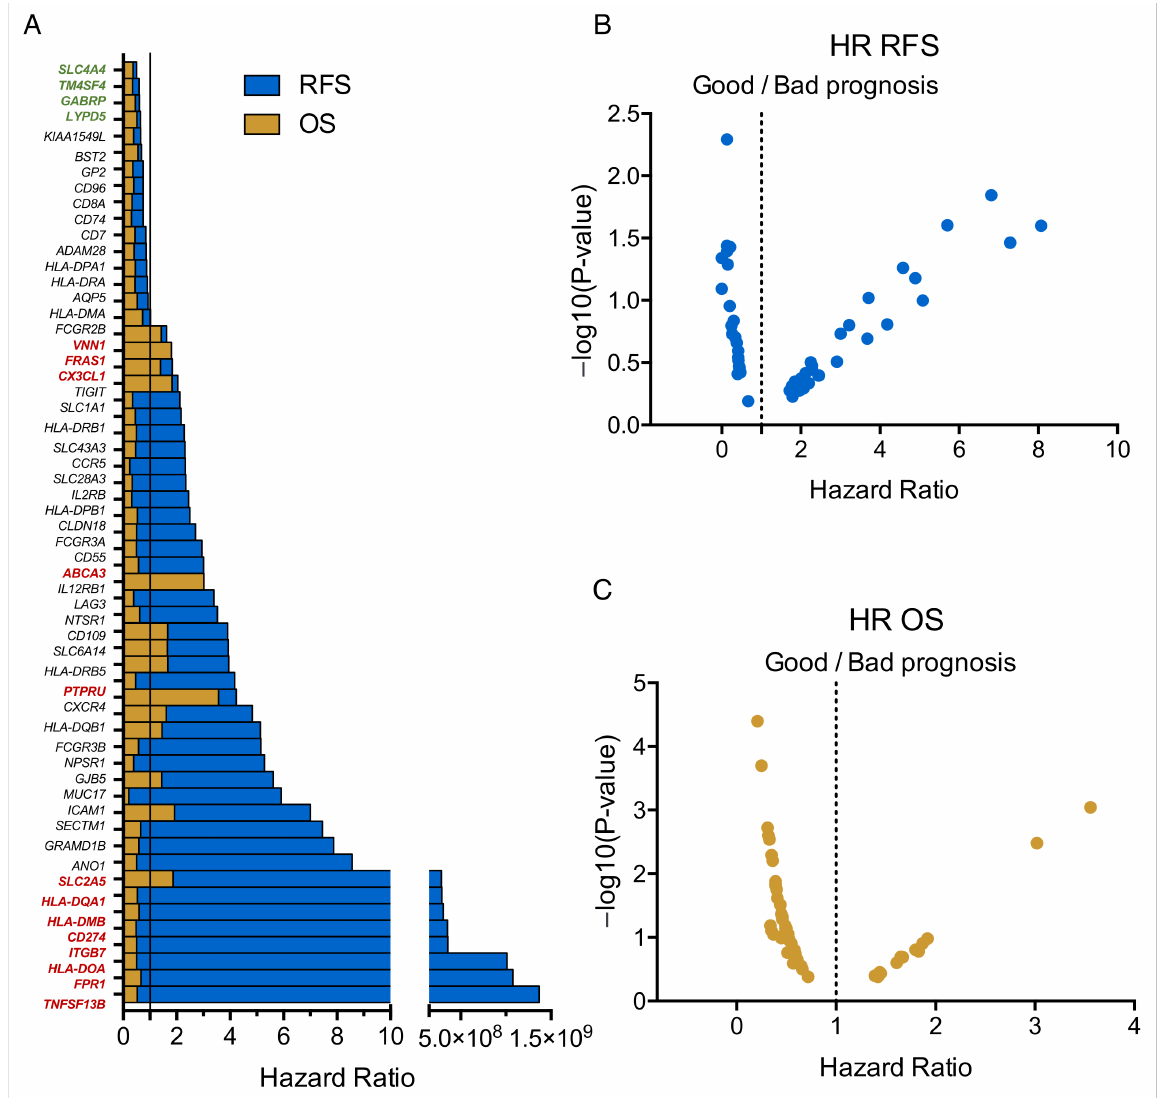
Figure 5. Correlation between upregulated genes and prognosis of patients with READ. ( A ) Bar graph showing the Hazard Ratio (HR) in relation to RFS (in blue) and OS (in yellow) of all 57 significantly upregulated genes that belongs to the surfaceome. Line at 1 separates good from bad prognosis. Genes highlighted in green are associated with good prognosis while those in red associate with worst outcome. Vulcano plot representing the p -value in Y axes and HR in X ones of RFS ( B ) and OS ( C ) of patients with READ. The dotted line at 1 separates good from bad